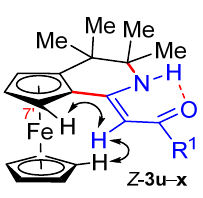
Figure 2. Key correlations in 2D 1 H ‒ 1 H NOESY spectra of compounds 3u ‒ x . Phenylacetonitriles 7a ‒ c , like nitriles 2a ‒ m , o ‒ s , u ‒ x , readily reacted with alcohol 1 to afford the corresponding ferroceno[ c ]pyridines 8a ‒ c . However, products 8a ‒ c could not be isolated in a pure form, since they were unstable. These compounds easily oxi- dized in air at a benzylic position, resulting in ferroceno[ c ]pyridines 9a ‒ c (Table 3).